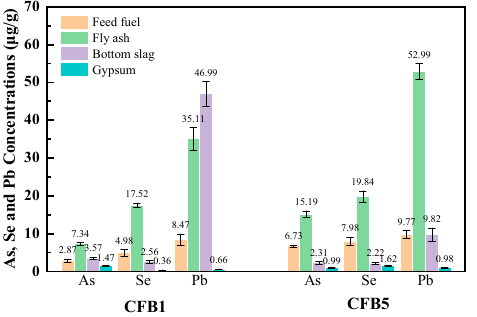
Figure 7. Distribution characteristics of As, Se and Pb in feed fuel, fly ash, bottom slag and gypsum of CFB1 and CFB5.